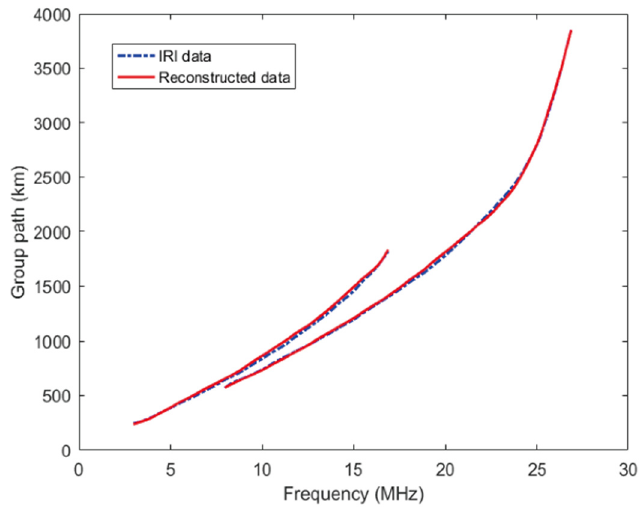
Figure 5. Comparison of the theoretical leading edge and real leading edge.